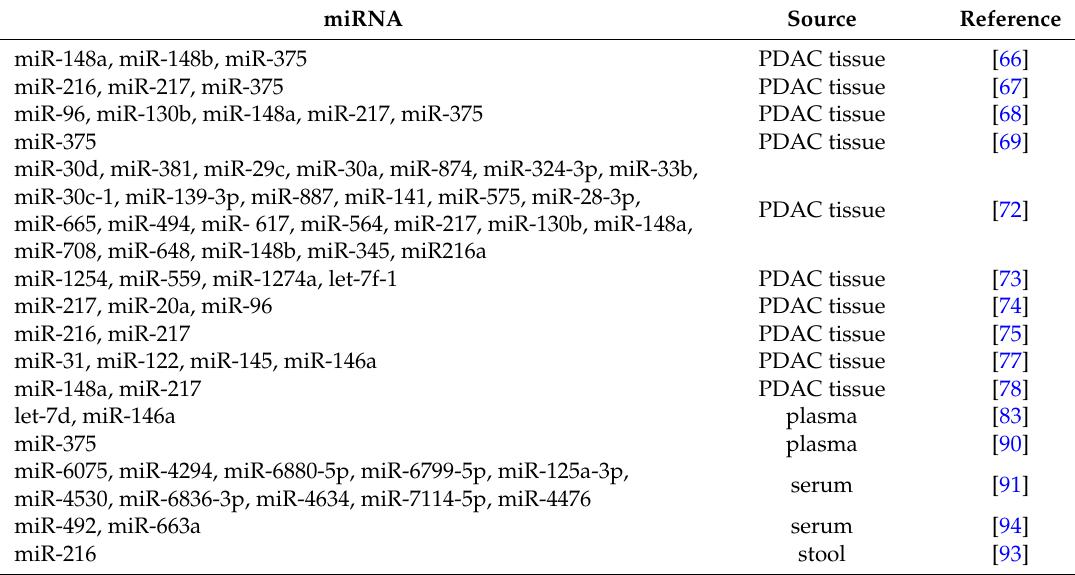
Table 2. miRNAs downregulated in PDAC compared to benign pancreatic pathology and/or healthy